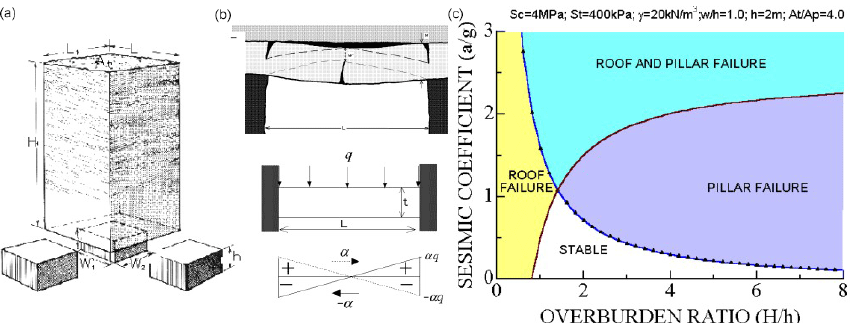
Figure 5. Mathematical model and example of computation for the stability of pillars and roof layers under dynamic conditions. See Aydan et al. (2006) for details. (a) Pillar. (b) Roof. (c) Example of